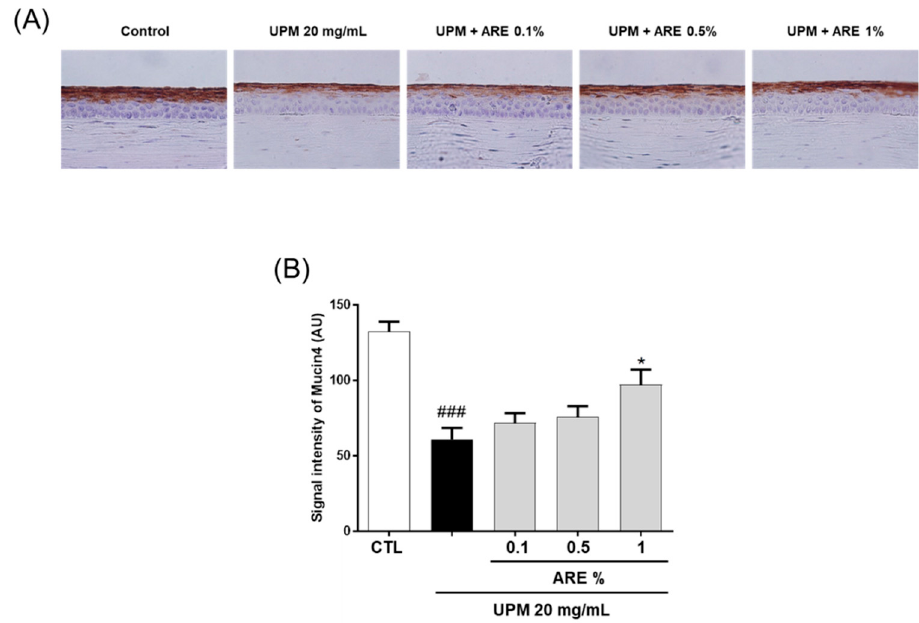
Figure 5. Achyranthis radix extract restored rMuc4 expression in the corneal epithelium. ( A ) Immunohistochemical staining of the corneal epithelium was performed by immunostaining the paraffin-embedded corneal sections for rMuc4. The immunostained sections were counterstained with hematoxylin. ( B ) Each bar represents mean rMuc4 fluorescence signal intensity ± SEM, n ≥ 5. ### p < 0.001 vs. control group, * p < 0.05 vs. UPM group. ARE, Achyranthis radix extract; UPM, urban particulate matter; CTL, control; AU, arbitrary units; SEM, standard error of mean.